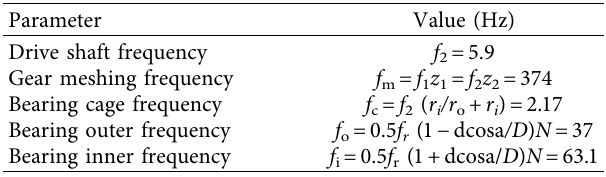
Figure 12: Te frst-second order of the wheel is not round. Table 2: Parameters of the system.